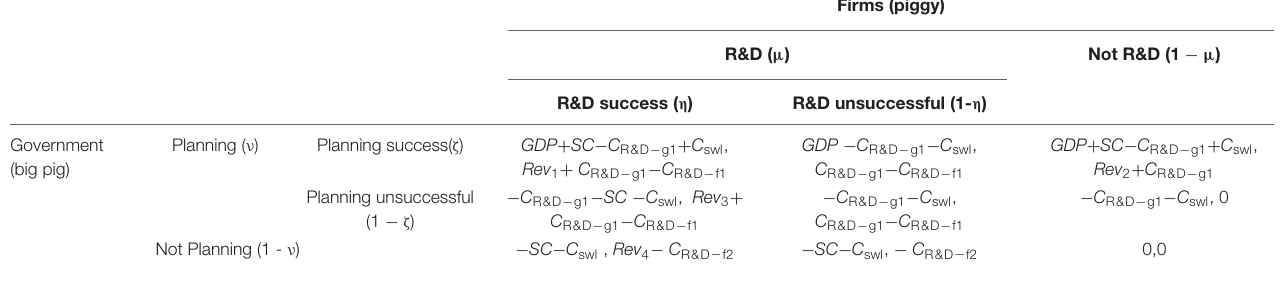
TABLE 3 | Smart pig game of government and